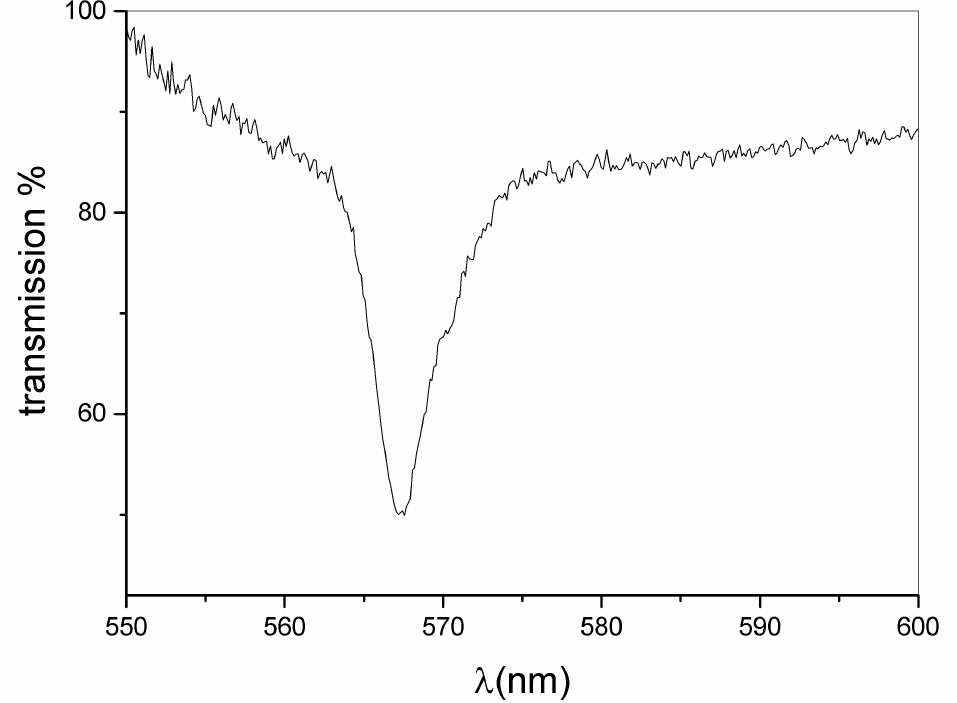
Figure 1. Typical normalized transmission spectrum showing the normalized reflection peak after the end of the recording